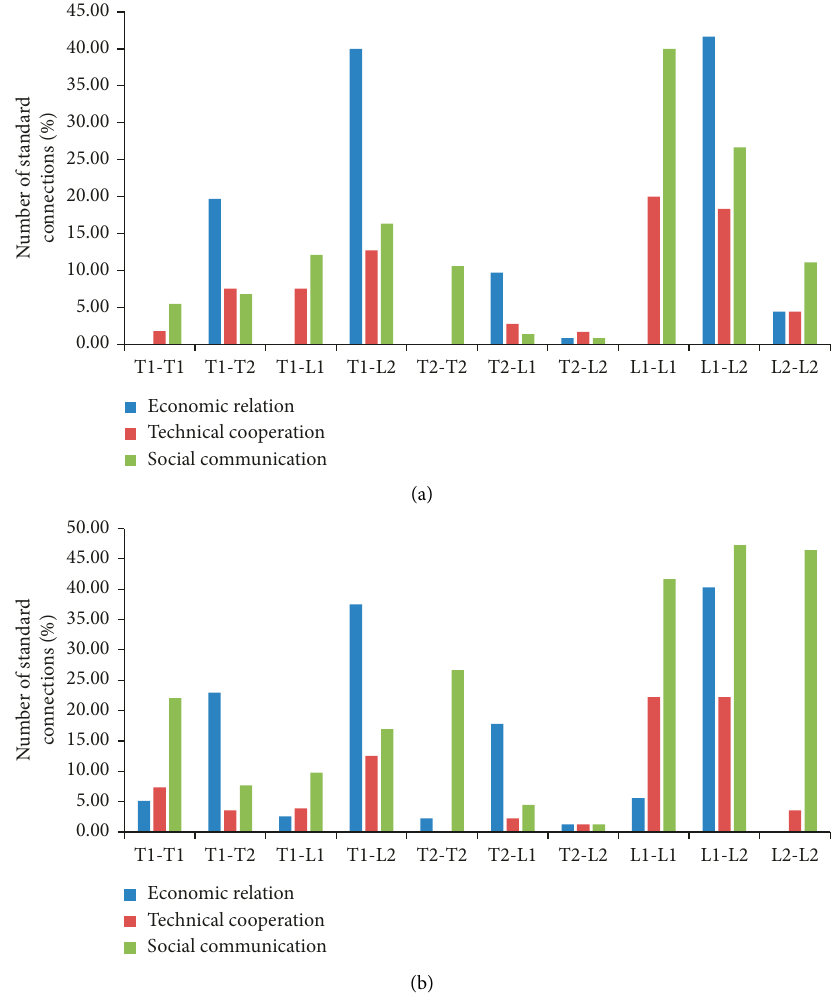
Figure 3: Number of standard connections for different types of firms in 2013 and